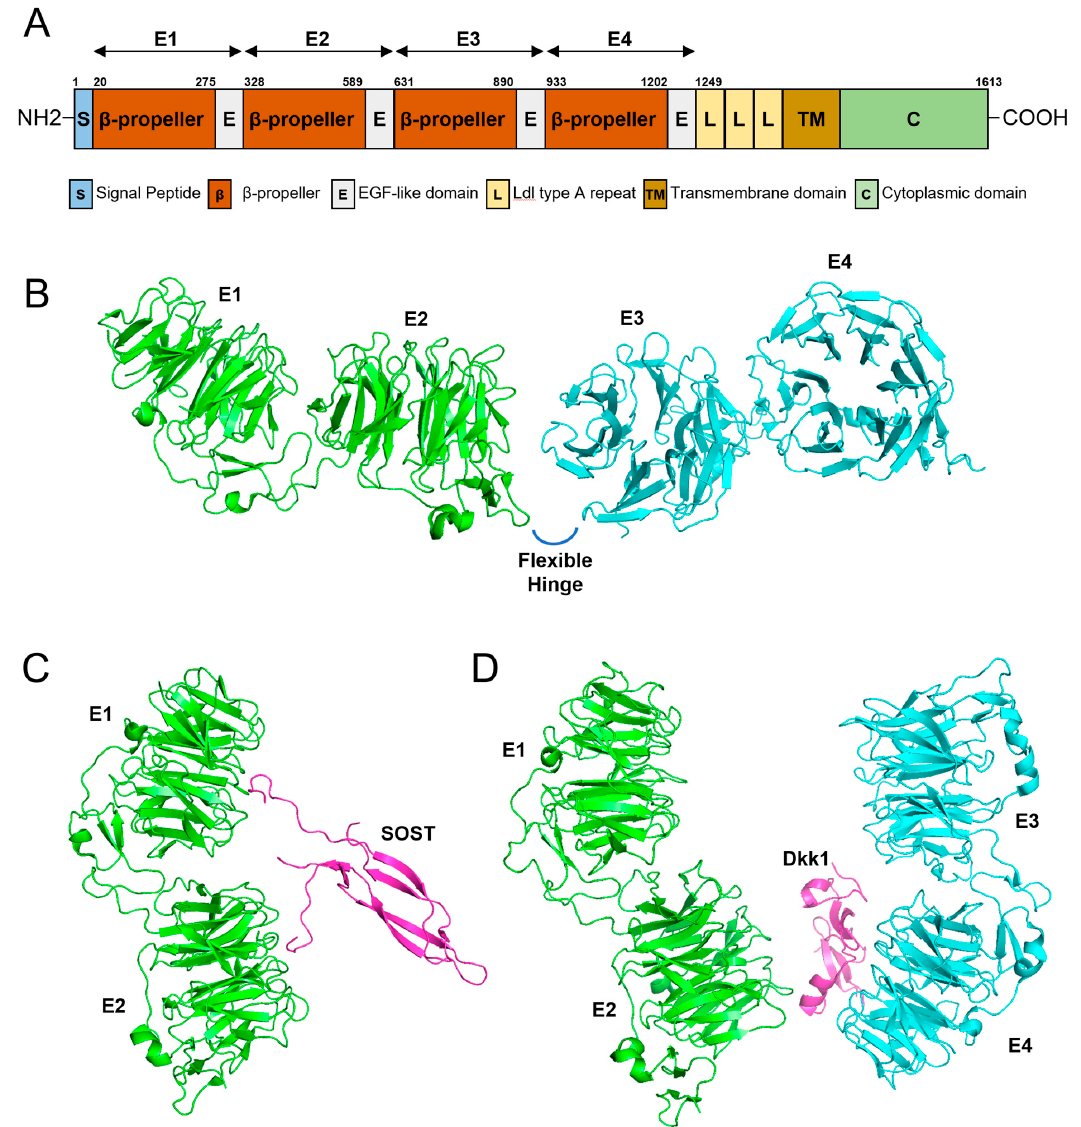
Figure 4. Gene diagram and 3D modeling. ( A ) Domain structure of LRP6. Amino acid numbers are shown above the diagram. Four β -propeller/EGF-like domain repeats (E1, E2, E3, and E4) are shown above the diagram with arrows. ( B ) 3D modeling of the four β -propeller/EGF-like domain repeats (E1, E2, E3, and E4). There is a flexible hinge between E2 and E3. ( C ) Three-dimensional modeling of E1 and E2 binding to SOST. ( D ) Three-dimensional modeling of the ectodomain of LRP6 complexed with Dkk1.